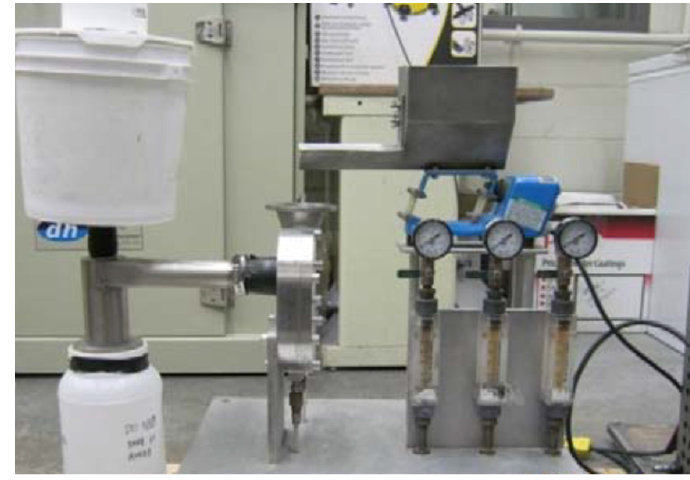
Figure 1. Picture of home ‐ made lab scale jet mill.